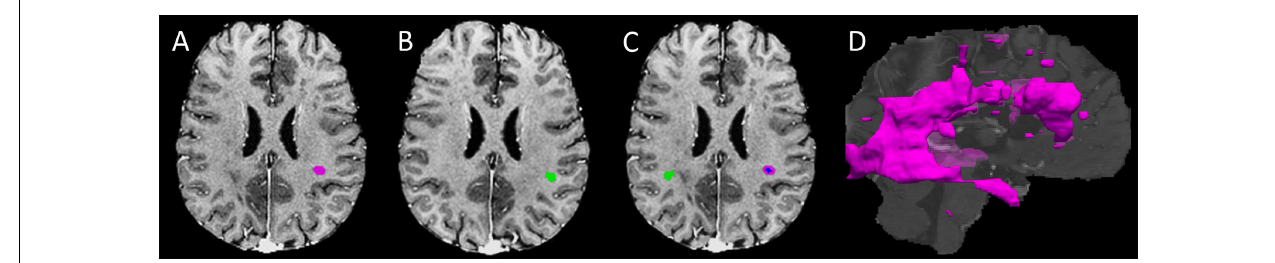
FIGURE 1 | Regions of interest development. (A) An example lesion region of interest (ROI) in the T1- FLAIR MRI space (purple mask); (B) A mirror-image of the T1-weighted MRI for developing the contralateral normal appearing white matter (NAWM) ROI (green mask) of the lesion shown in panel A ; (C) the finalized contralateral NAWM ROI of the lesion produced using ( panel A,B ), along with converse co-registration between the corresponding image volumes; the blue and purple areas within the lesion represents the core and shell ROIs, respectively; and (D) 3D whole brain lesion masks produced by grouping adjacent ROI voxels within and between slices.